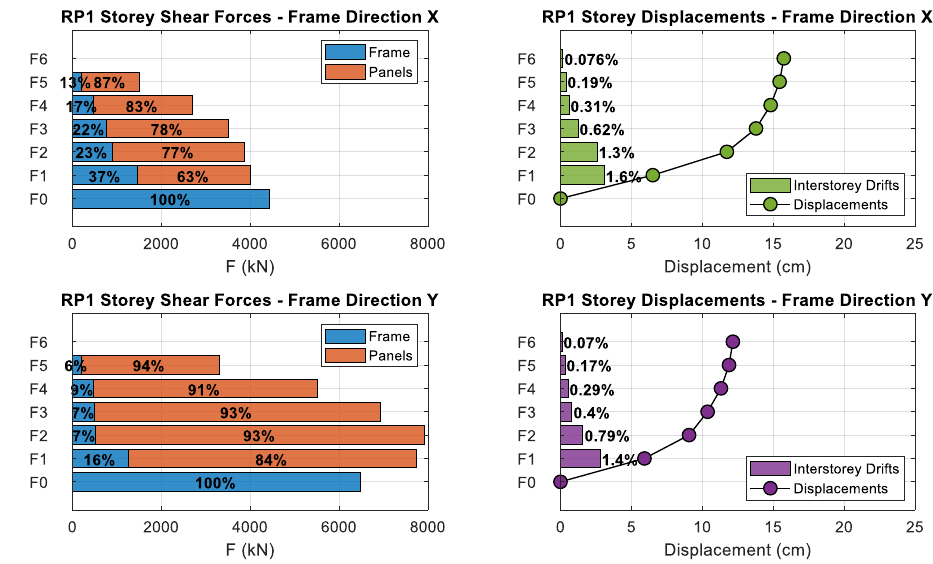
Figure 13. RP1 storey shear forces and displacements.